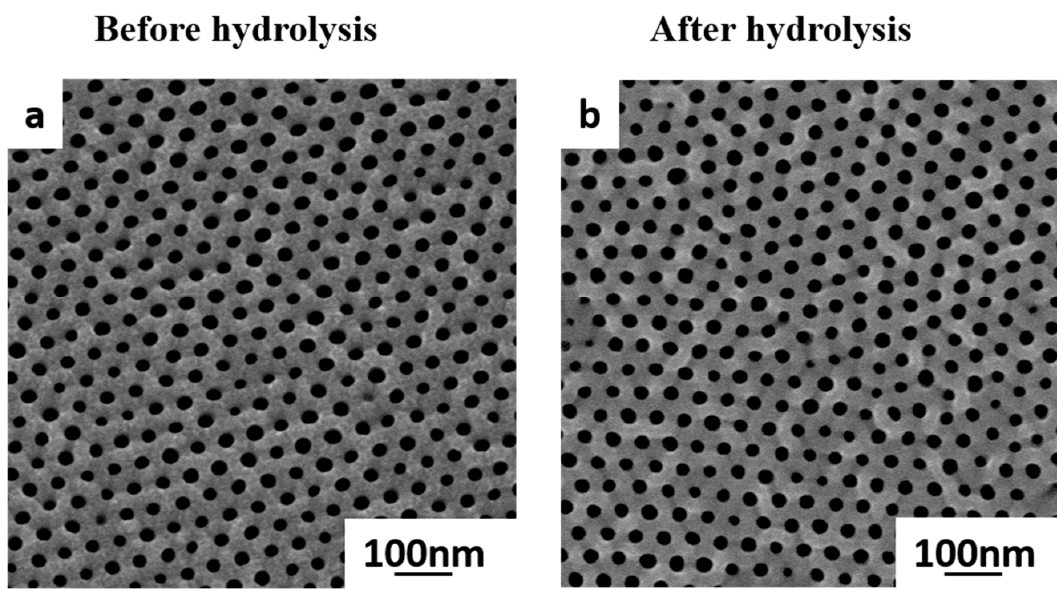
Figure 4. ( a ) SEM images of pristine PS 71 - b -P4VP 26 - b -PSMA 3145 membrane before acidic hydrolysis and ( b ) PS 71 - b -P4VP 26 - b -PGMA 3145 membrane.